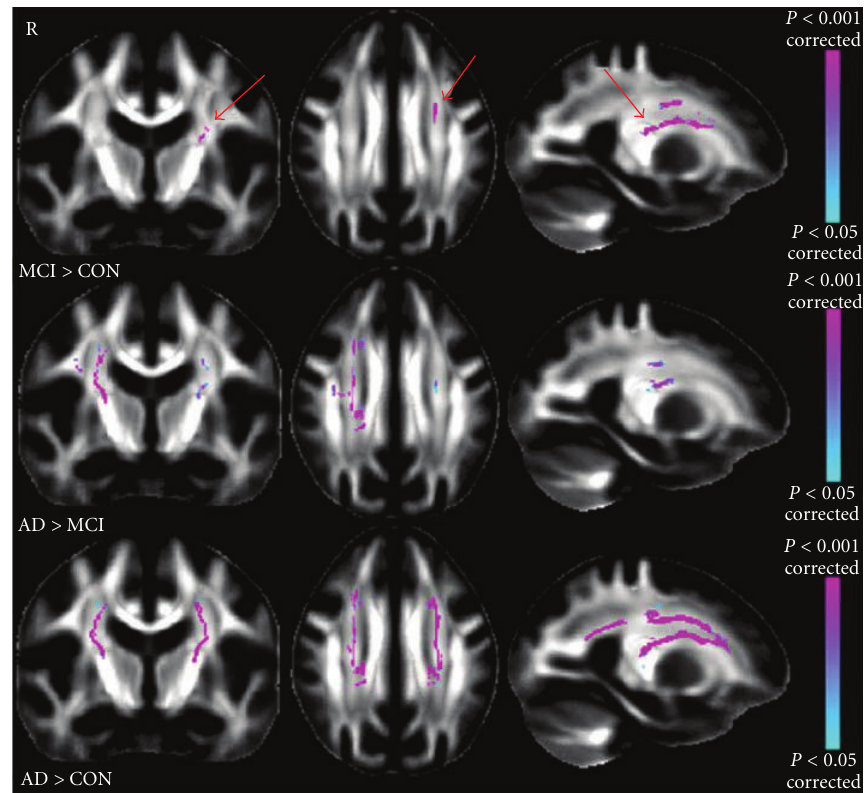
Figure 7: Top. Significant mode of atrophy (MO) results showing the contrast MCI > CON (controls; arrows). Middle. Significant MO results showing the contrast AD > MCI. Bottom. Significant MO results showing the contrast AD > CON. (adapted with permission from